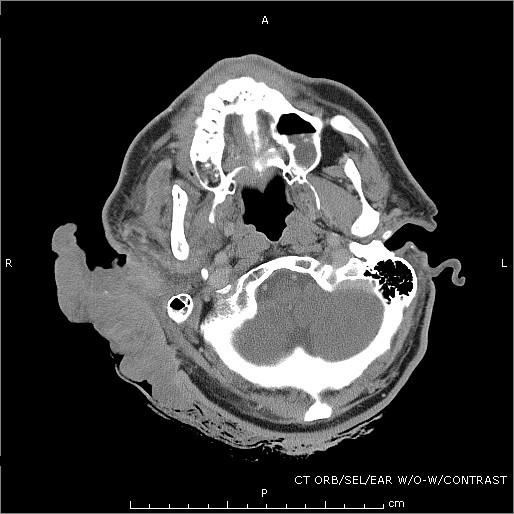
Ear cross section.